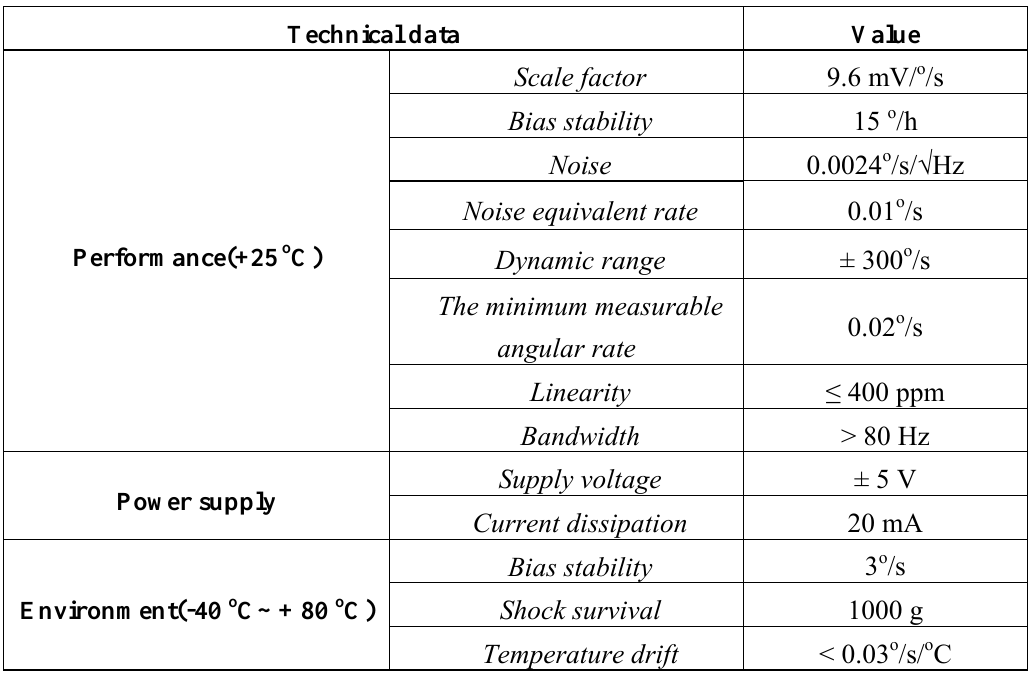
Table 2. Performance index of miniature microgyro